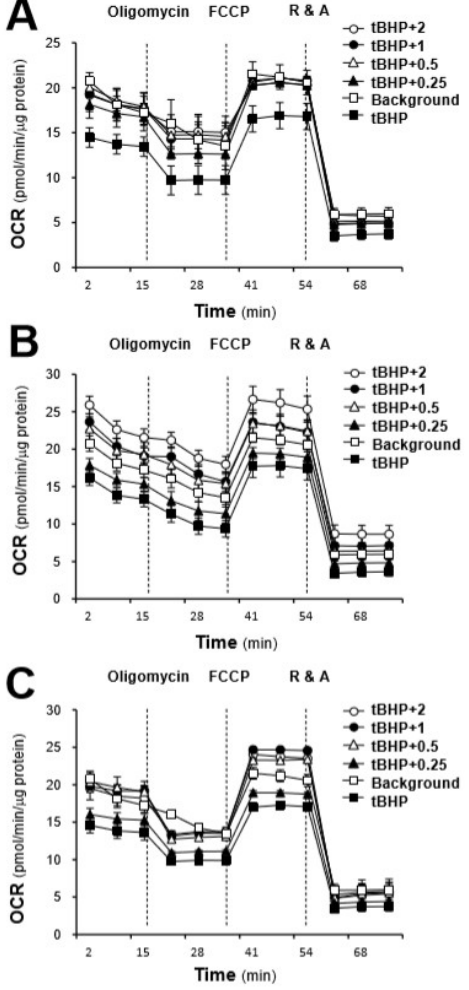
Figure 5. The AR extracts modulate the mitochondrial bioenergetics of H9C2 cells. Cultured H9C2 cells were treated with the AR extracts (from 0.25 to 2 mg/mL as indicated) for 24 h before measuring the oxygen consumption rate (OCR) with the XFp Cell Mito Stress Test. The responses of H9C2 cells after oligomycin (1 μM), FCCP (3 μM), and rotenone/antimycin A (R&A at 1 μM) treatments were recorded. The dotted lines denote the times at which the three inhibitors were applied. Effects of various extracts of AR: ( A ) water extract of AR, ( B ) 50% ethanol extract of AR, ( C ) 90% ethanol extract of AR, at various concentrations on the OCR for four respiration states of H9C2 cells are shown. The OCR values were normalized with respect to the cellular protein content/well. The background are the untreated cell. The data are expressed as mean ± SD, n = 3; each experiment was performed with triplicate